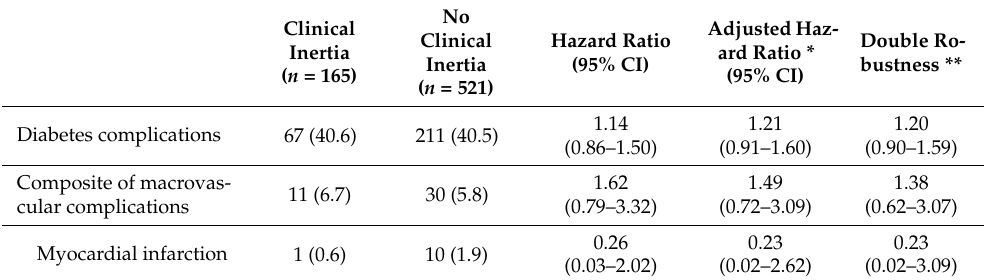
Table A3. Hazard ratios showing the effect of clinical inertia on diabetes complications by IPTW analysis ( n =